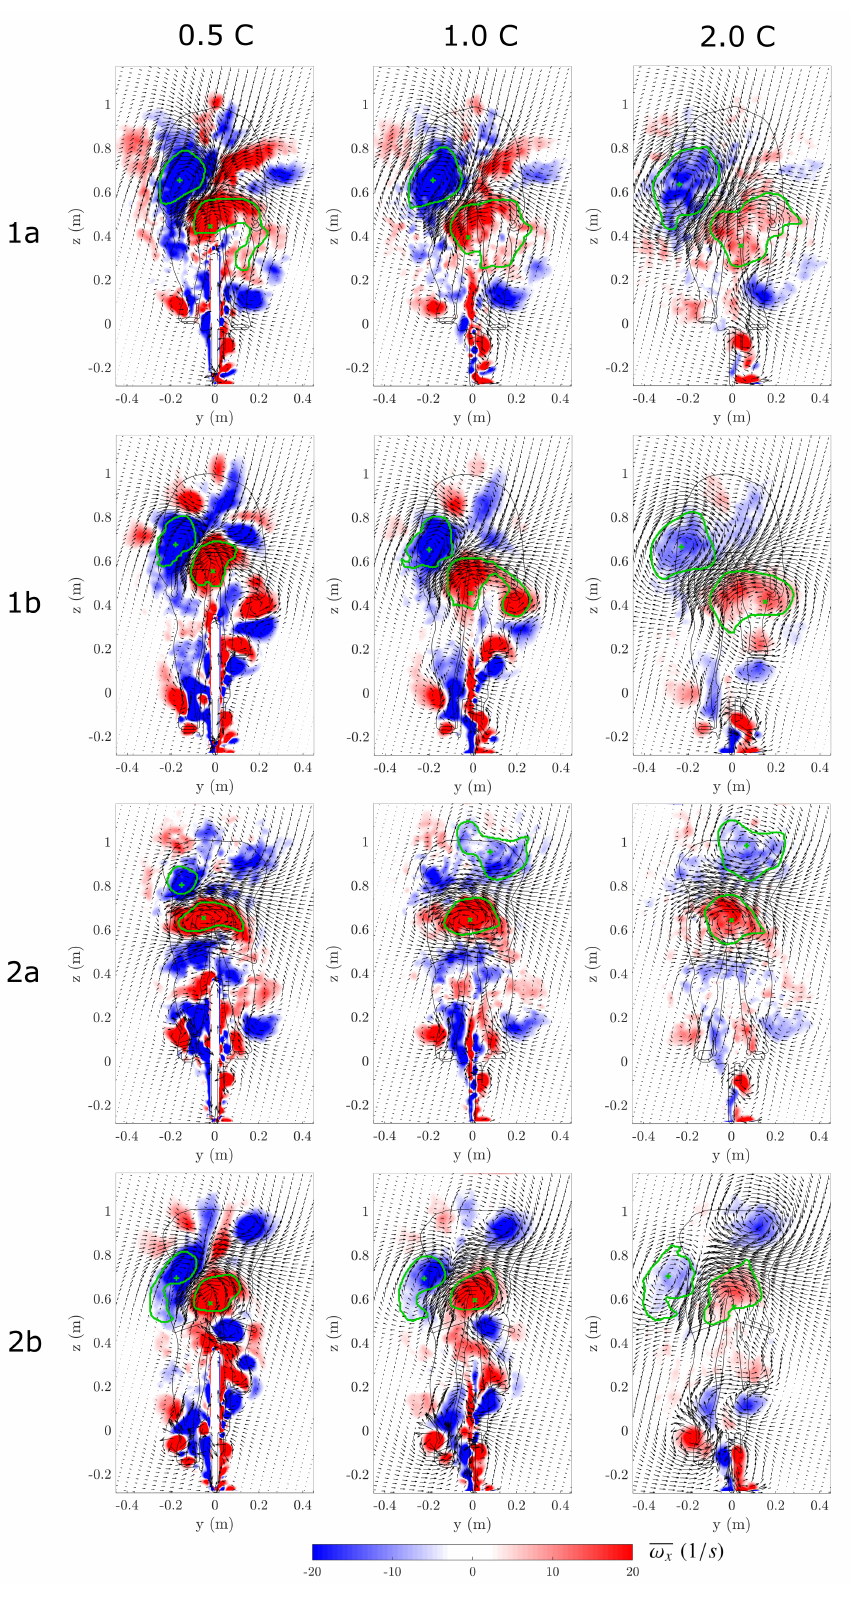
Figure 8. The wake propagation depicted by ω x and in-surface projected velocity vectors at 0.5, 1 and 2 C behind the cyclist, with the boundaries of dominant vortices visualized by green lines and their core location highlighted by green crosses (x). The outlines of the cyclist and bicycle are plotted to show the relative position between the wake and